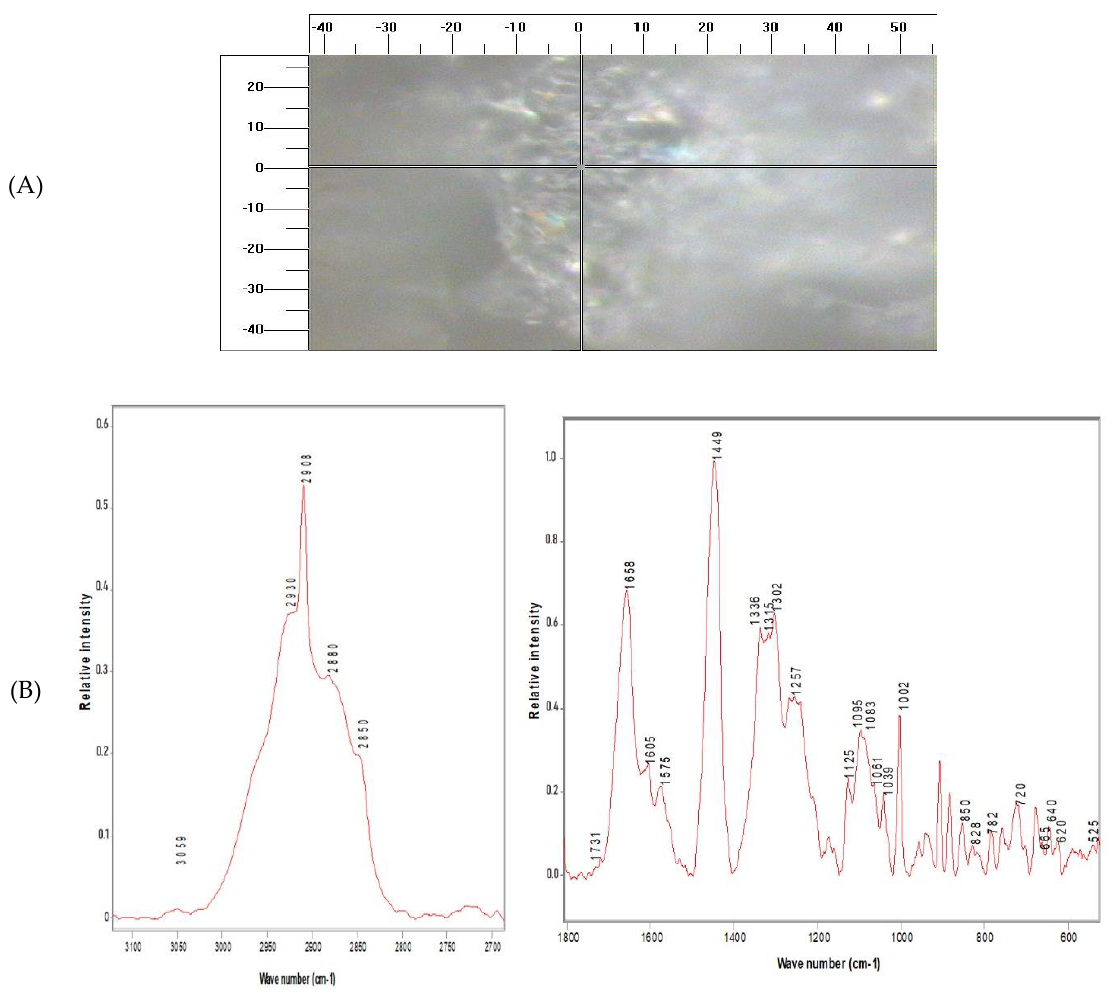
Figure 3. Raman microscopy (RM) of: ( A ) Caco-2 cells under 100 × objective; ( B ) Raman spectra (a) 2700–3100 cm − 1 and (b) 1800–600 cm − 1 regions obtained from untreated cells.